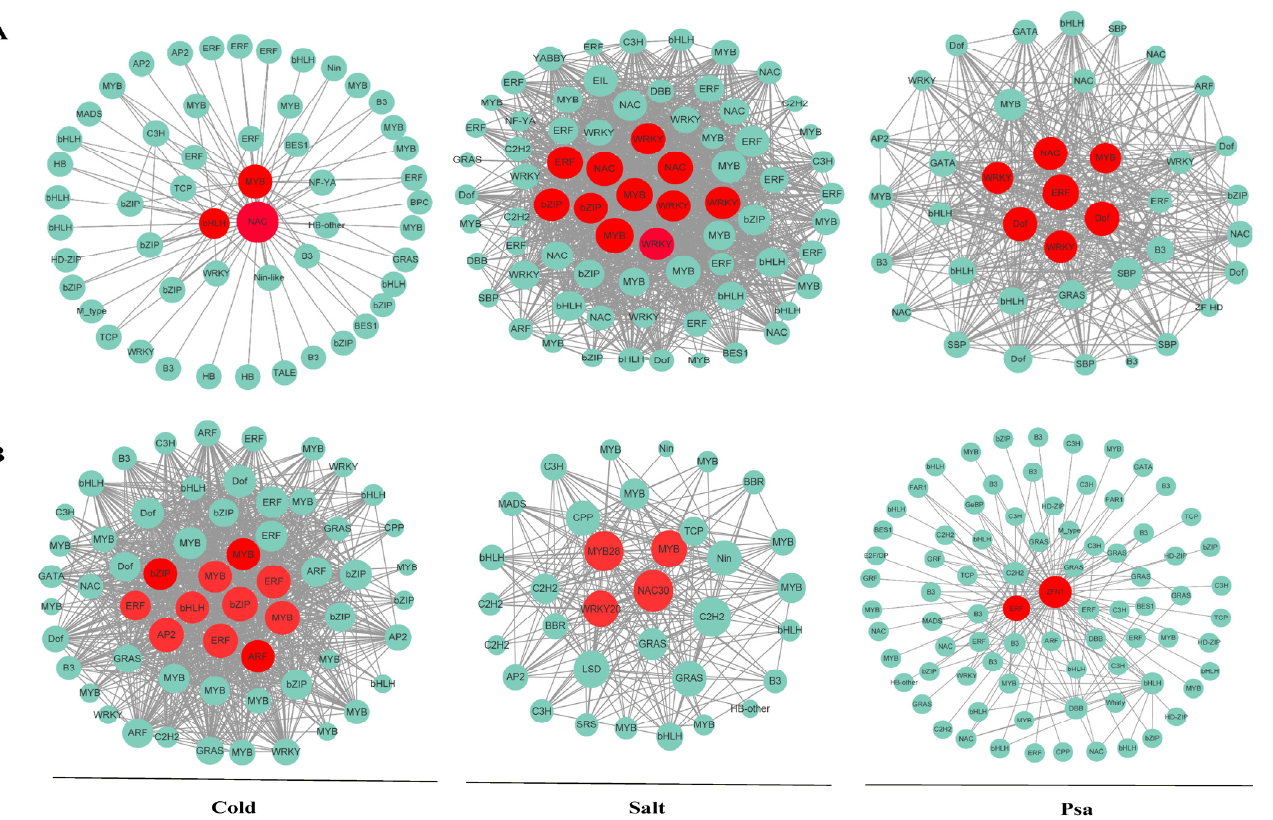
Figure 6 . Network maps of hub TF targeting key AcGolS ( A ) and AcRFS ( B ) genes under cold, salt and Psa stresses. An adjusted network map of a subset of the module genes interacts with the hub TF genes (weight of >0.5).